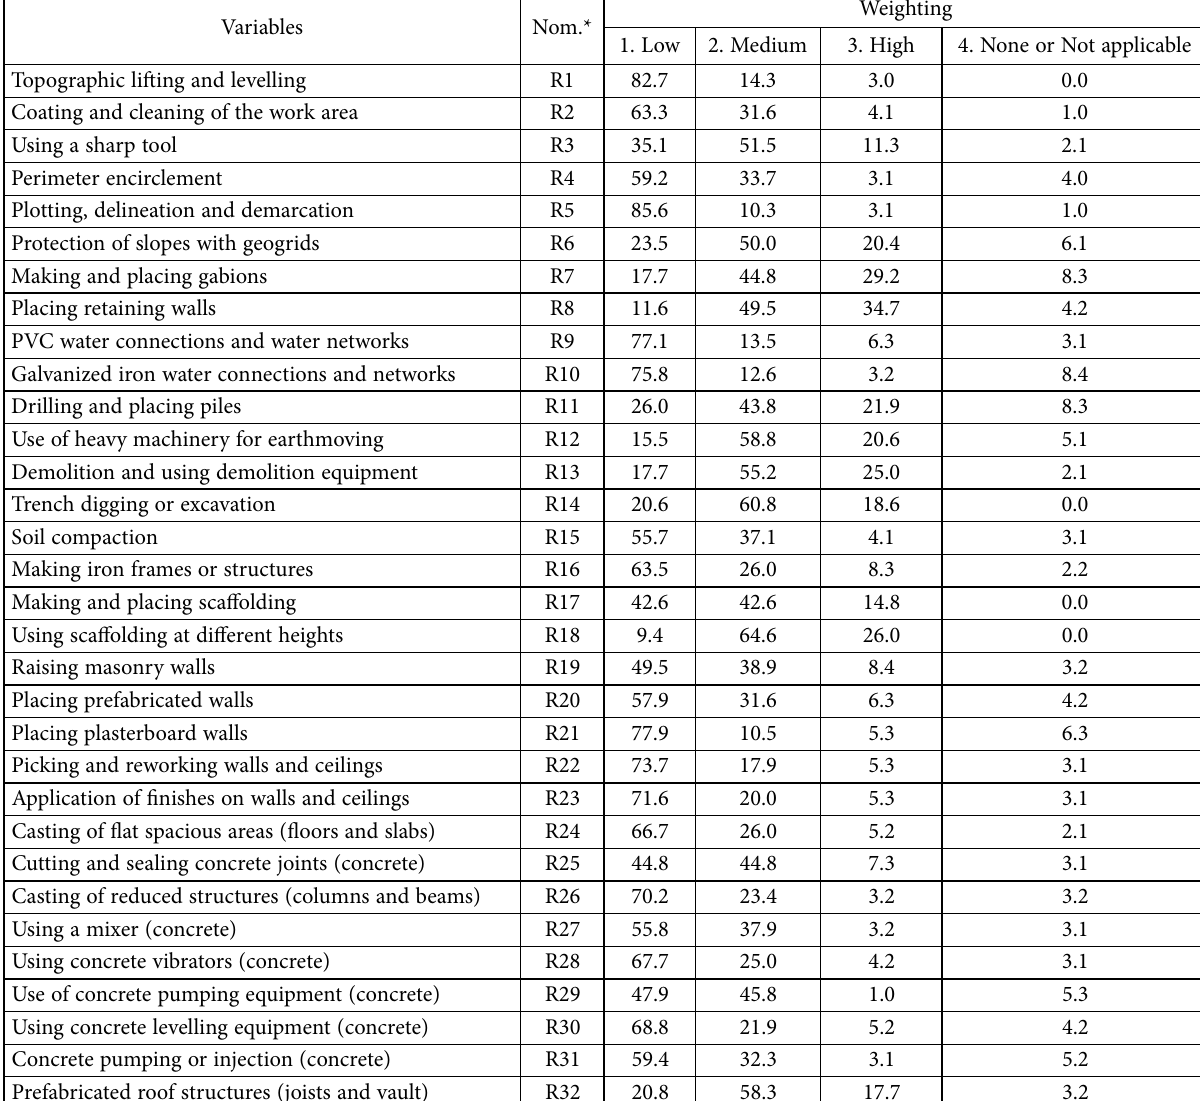
Table 1. Frequencies of the 64 risk-weighting variables in each construction activity (Part